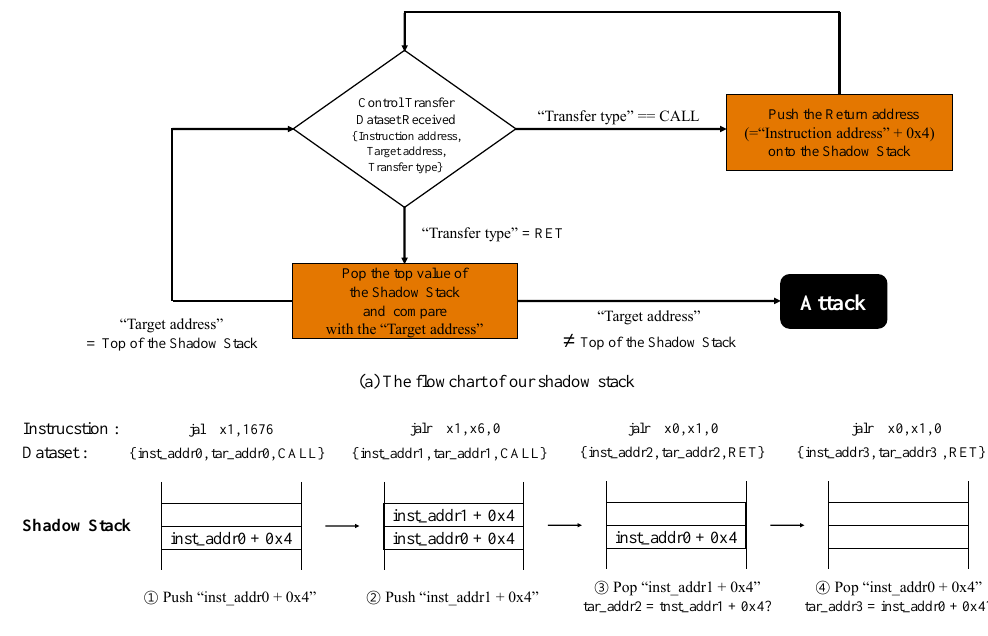
Figure 4. The Concept of Shadow